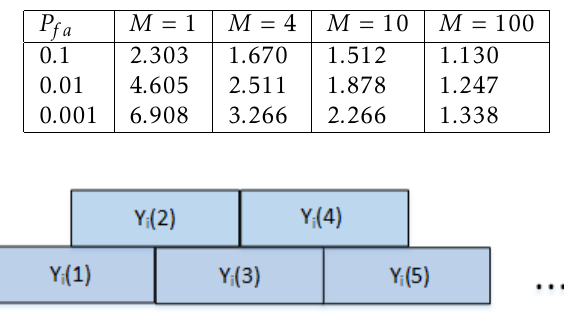
Table 1. Threshold parameter values T for different P values.